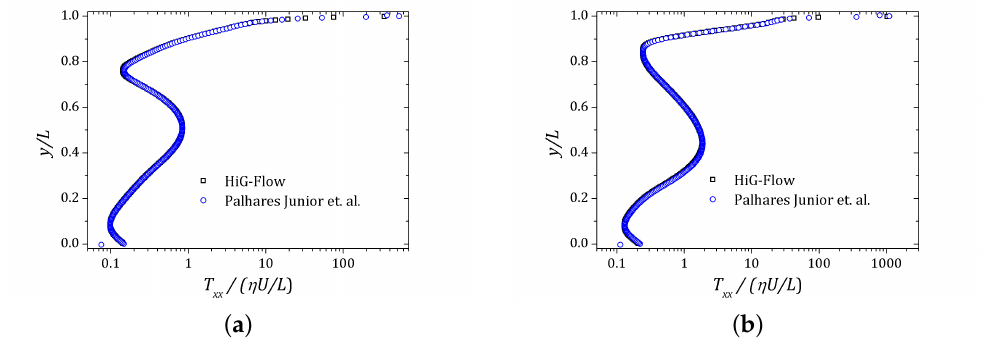
Figure 7. Velocity field v obtained along the horizontal line y = 0.75: ( a ) De = 1.0; ( b ) De = 2.0.